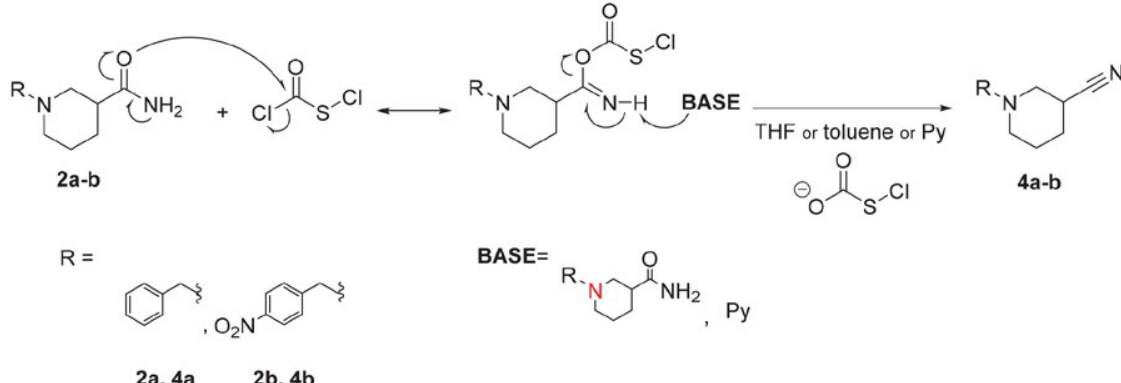
Figure 5. The proposed mechanism of dexydration of primary amides to nitriles using chlorocarbonylsulfenyl